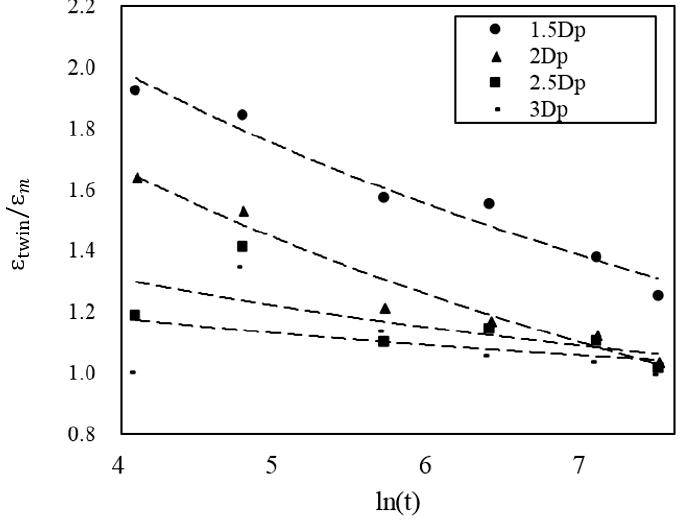
Figure 6. Relationship between ε twin / ε m and ln (t).